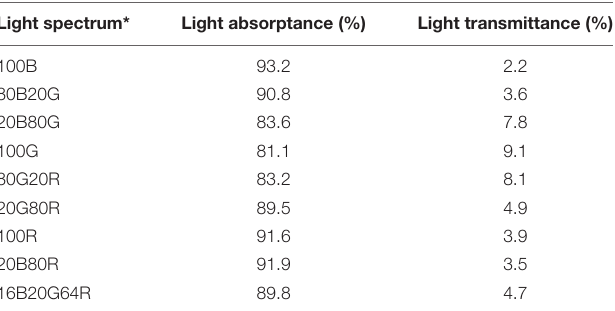
TABLE 2 | Light absorptance and transmittance of new fully expanded “Green towers” lettuce leaves under nine light spectra. Light spectrum* Light absorptance (%) Light transmittance